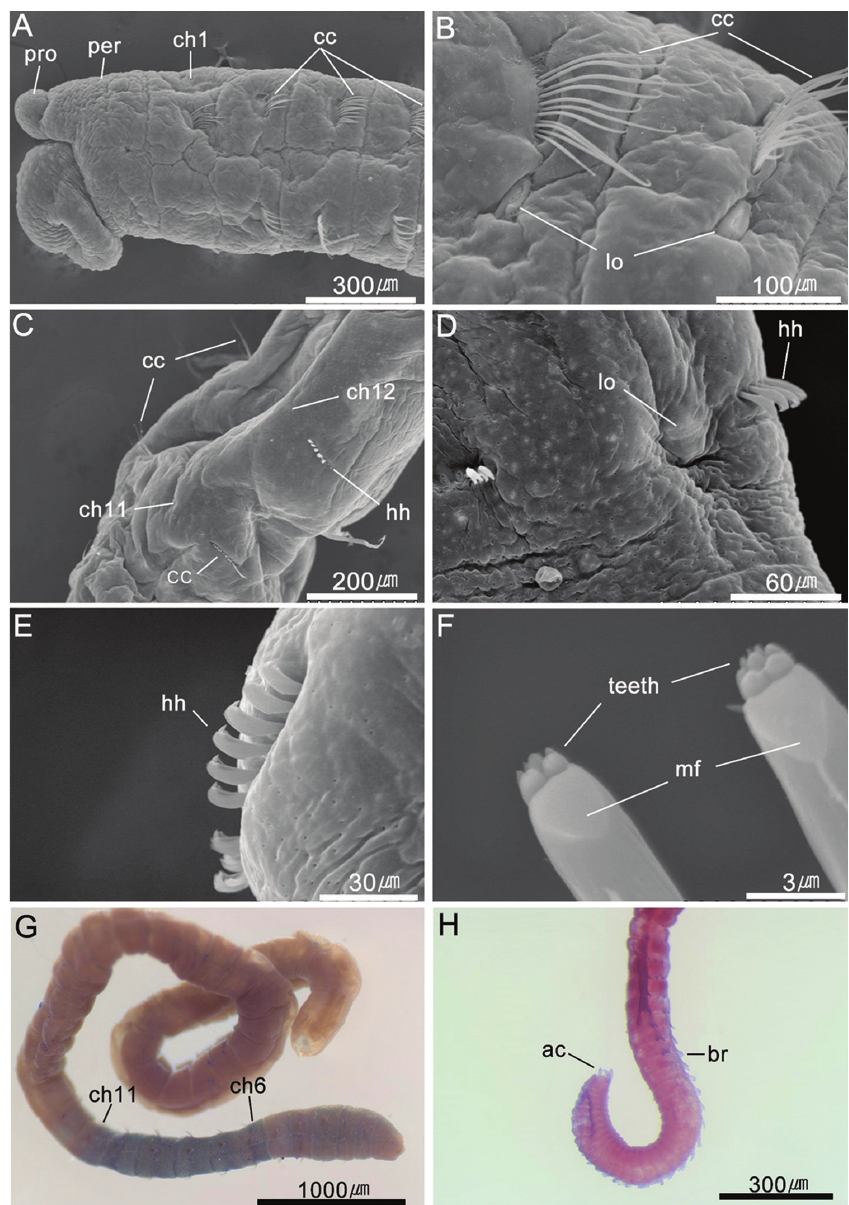
Figure 3. Leiochrides yokjidoensis sp. n. A−F scanning electron micrographs A anterior end in left lateral view B chaetigers 4–5 in left dorsolateral view C chaetigers 11–12 in left lateroventral view D chaetiger 15 in left lateral view E notopodial hooded hooks of chaetiger 16 F neuropodial hooded hooks of chaetiger 16 in frontal view G–H photomicrographs G thorax and anterior abdomen, right lateral view showing methyl green staining reaction H posterior end of body in left lateral view (MABIKNA00145754). Ab- breviations: ac, anal cirri; br, branchia; cc, capillary chaeta; ch, chaetiger; hh, hooded hook; lo, lateral organ; mf, main fang; per, peristomium; pro,